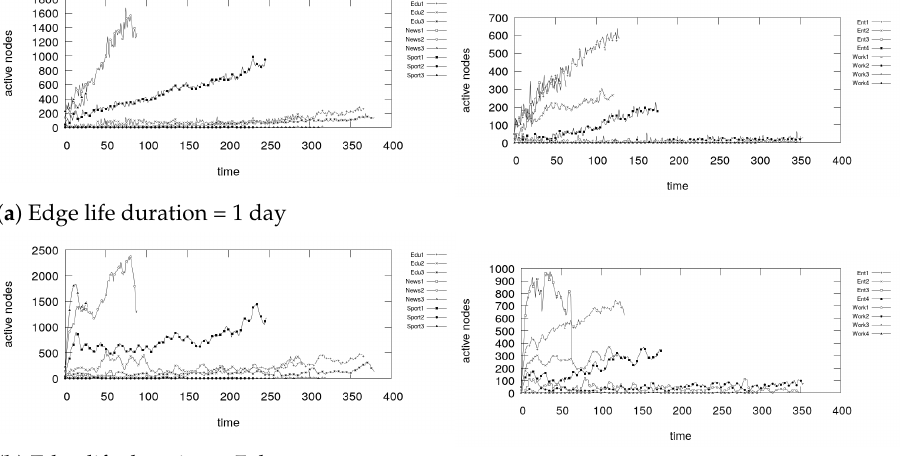
Figure 10. Number of active nodes detected by